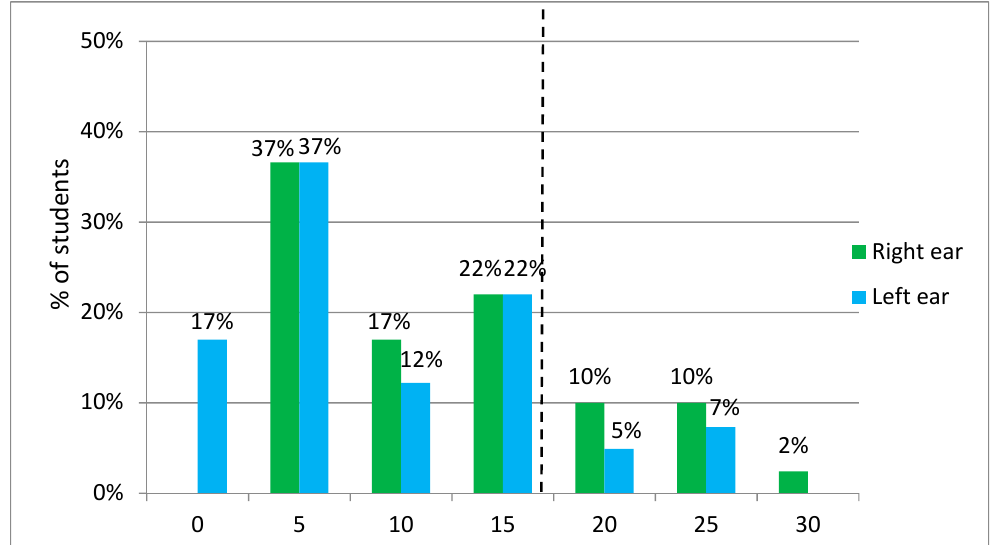
Figure 3. Hearing thresholds for pure tones at 8000 Hz—right and left ear ( n = 41). Note: On the right side of the dotted line are subjects exceeding the threshold (16 dB).